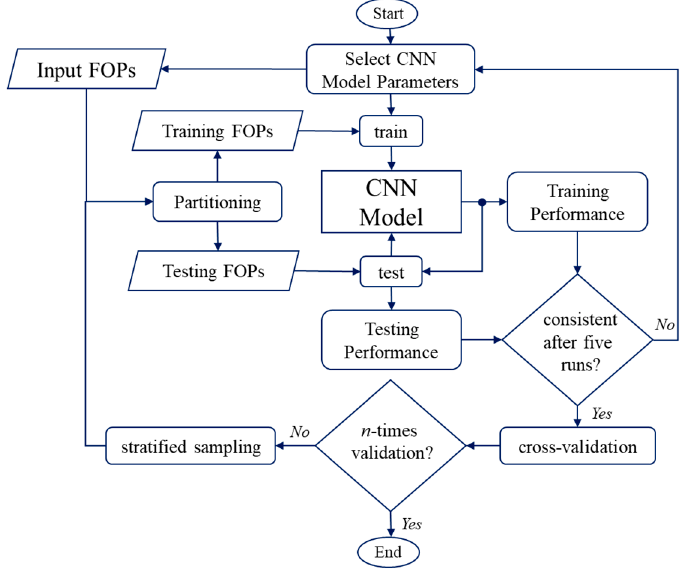
Figure 8. A supervised deep learning pseudocode for CNN model with validation.